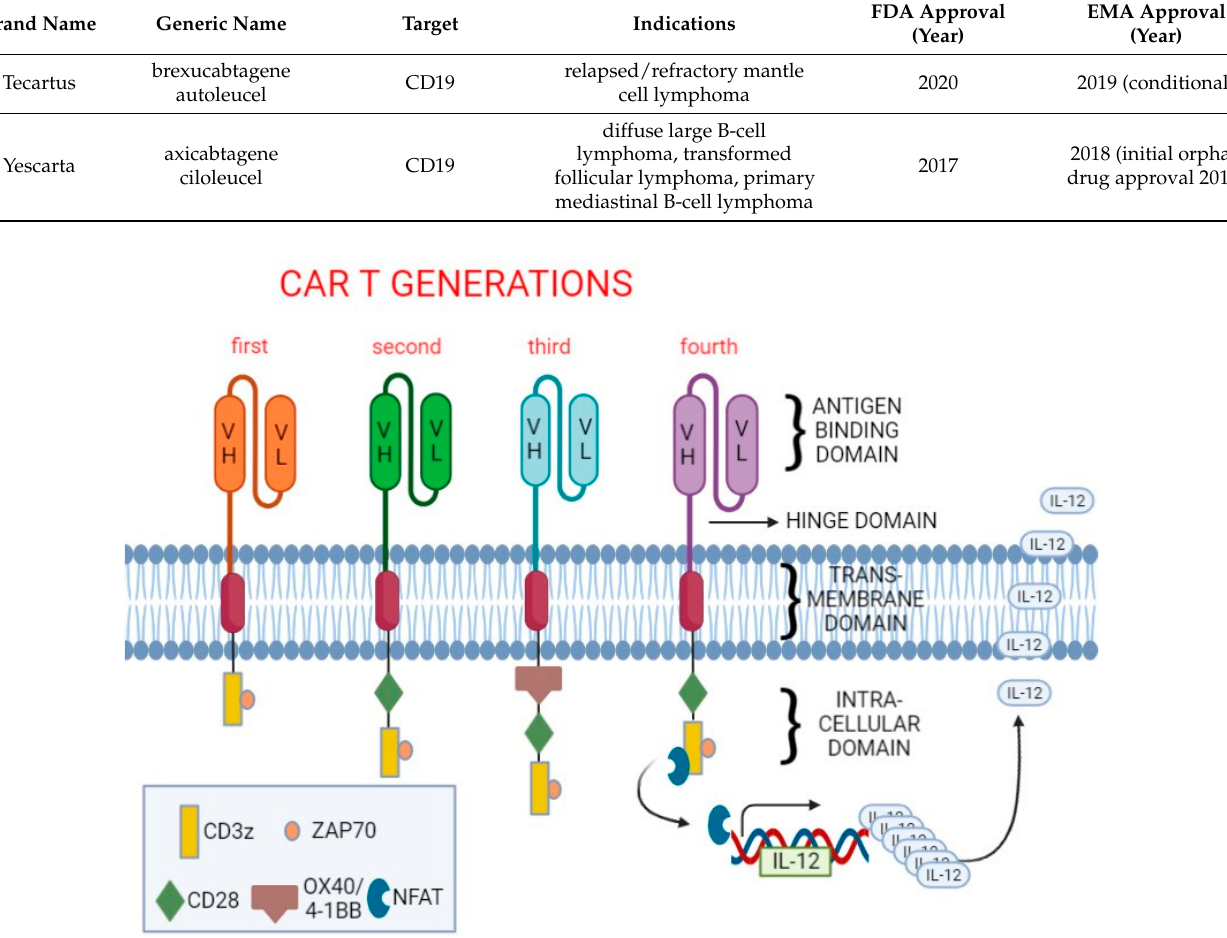
Figure 1. Diagrammatic representation of chimeric antigen receptors (CARs).